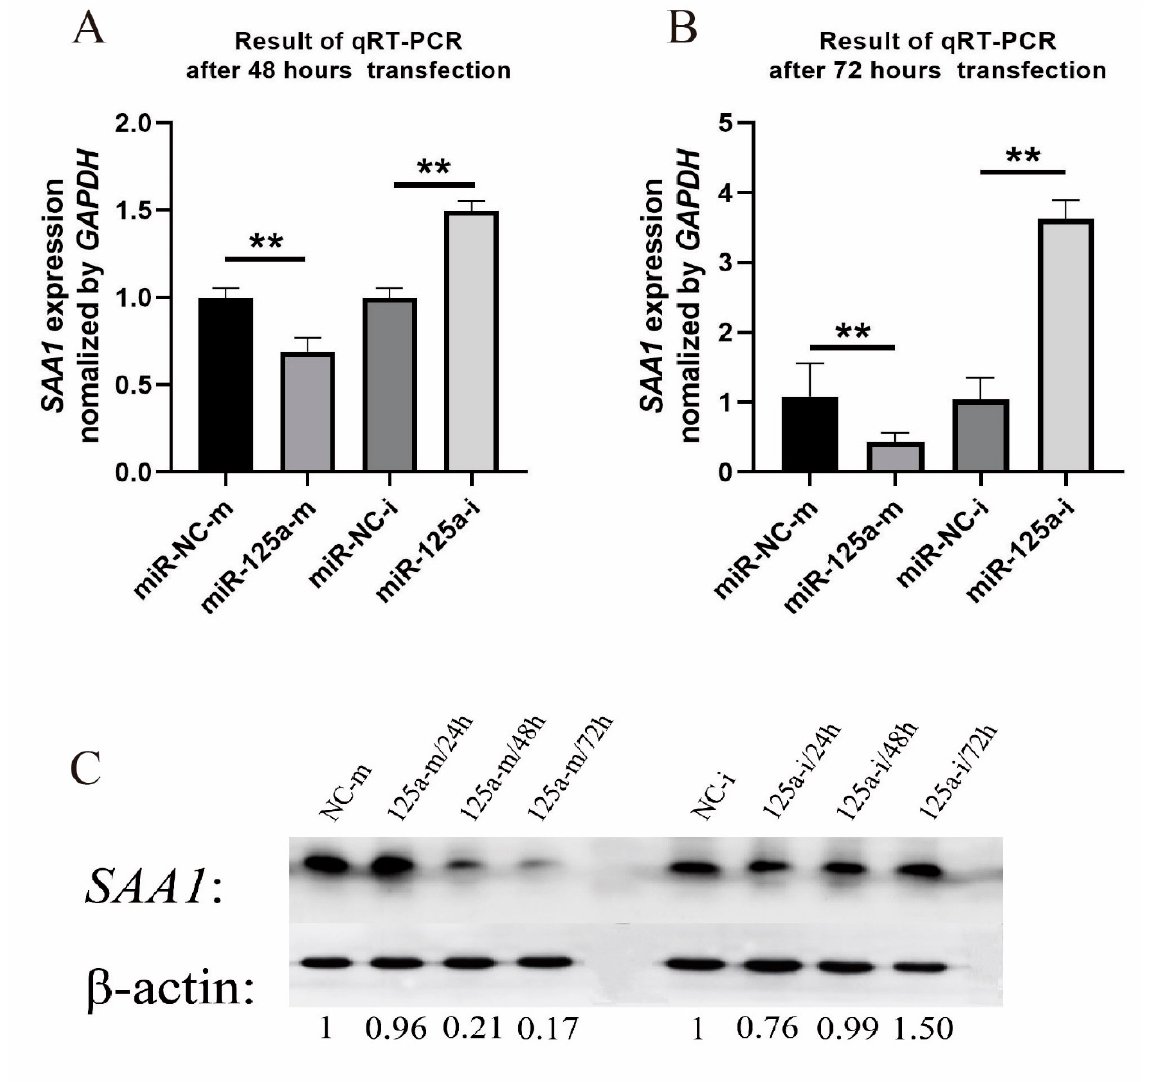
Figure 4. MiR-125a regulates SAA1 expression in dairy cow mammary epithelial (MAC-T) cells. ( A ) Results of qRT-PCR: the expression of SAA1 at 48 and 72 hours after transfection; ( B ) Western blotting result map and quantification; PhotoShop was used to calculate the gray values; ( C ) Western blot of SAA1 and their negative controls using β -actin as a reference control. ** Very significant difference between the control and the treatment ( p < 0.01).